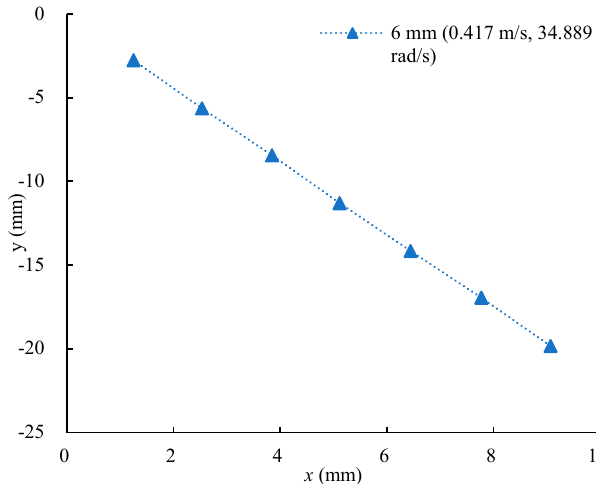
Figure 2. The trajectory of a 6 mm sphere.